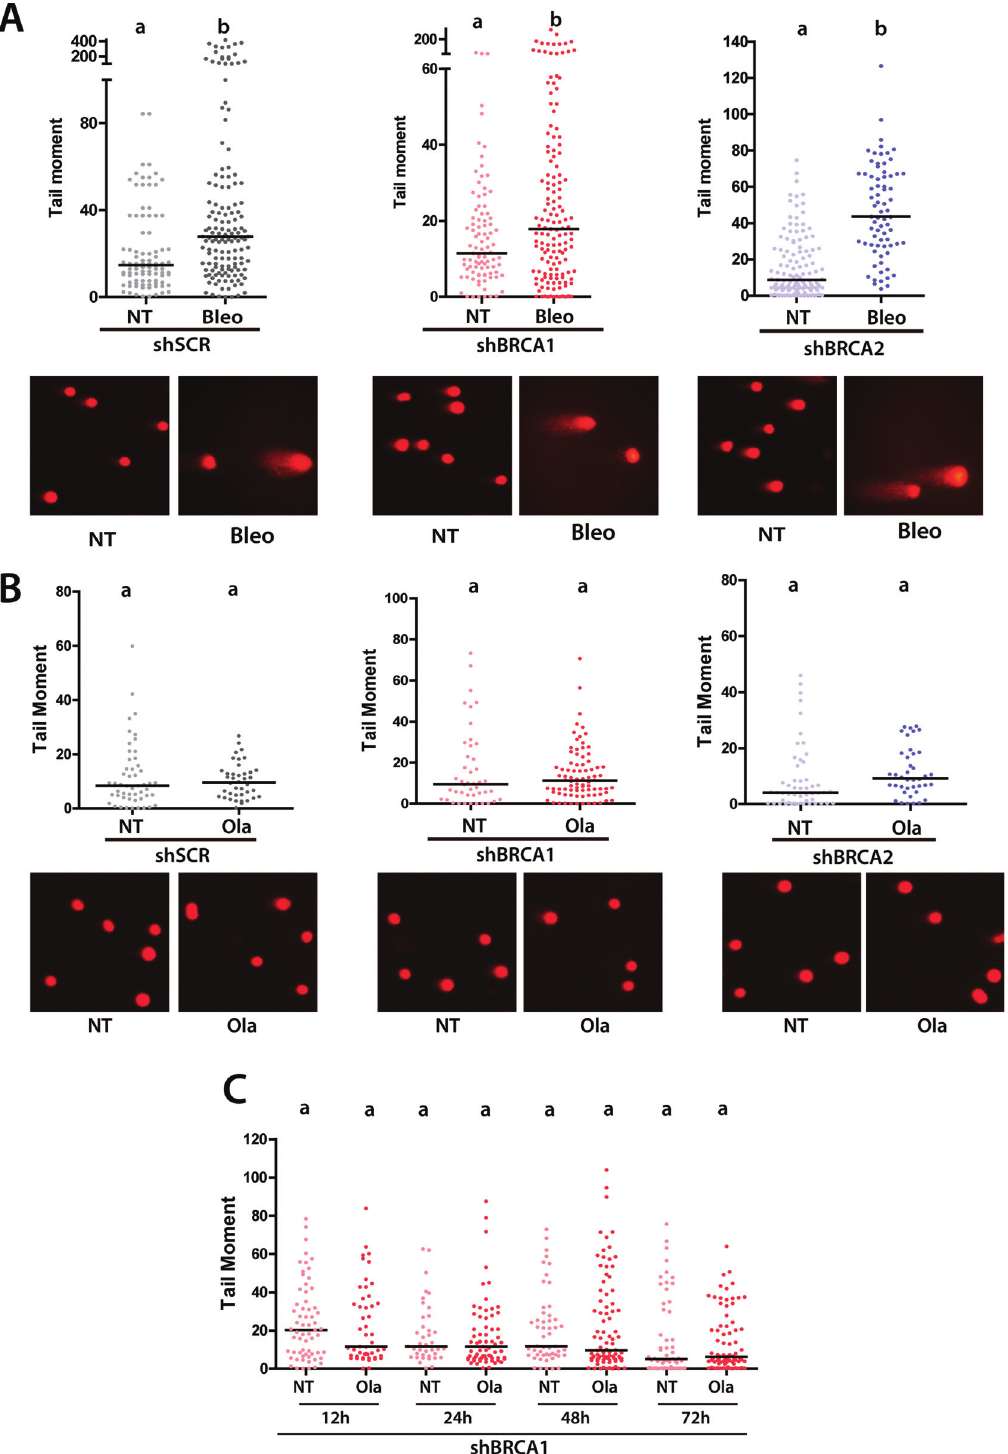
Figure 4 - Persistent double-strand break accumulation does not precede Olaparib-triggered cell death in BRCA-deficient HCT116 p21-/- cells. A) HCT116 p21-/- cells transduced with shSCR, shBRCA1 and shBRCA2 were submitted to neutral comet assay in untreated and Bleomycin-treated condi- tions (mean +SD, n= 2). B) HCT116 p21-/- cells transduced with shSCR, shBRCA1 and shBRCA2 were submitted to neutral comet assay two days after Olaparib treatment, which coincides with the maximum levels of (cid:3) H2AX accumulation. Results are representative of 2 independent experiments. C) HCT116 p21-/- cellstransducedwithshSCRandshBRCA1weresubmittedtoneutralcometassayattheindicateddaysafterOlaparibtreatment.Resultsare representative of 2 independent experiments. Statistical analysis was performed using One Way ANOVA with Dunns comparison test and differences were considered significant with p (cid:7) 0.05. The bars on top of the distribution clouds indicate the median. The letters above the different values indicate groups that are significantly